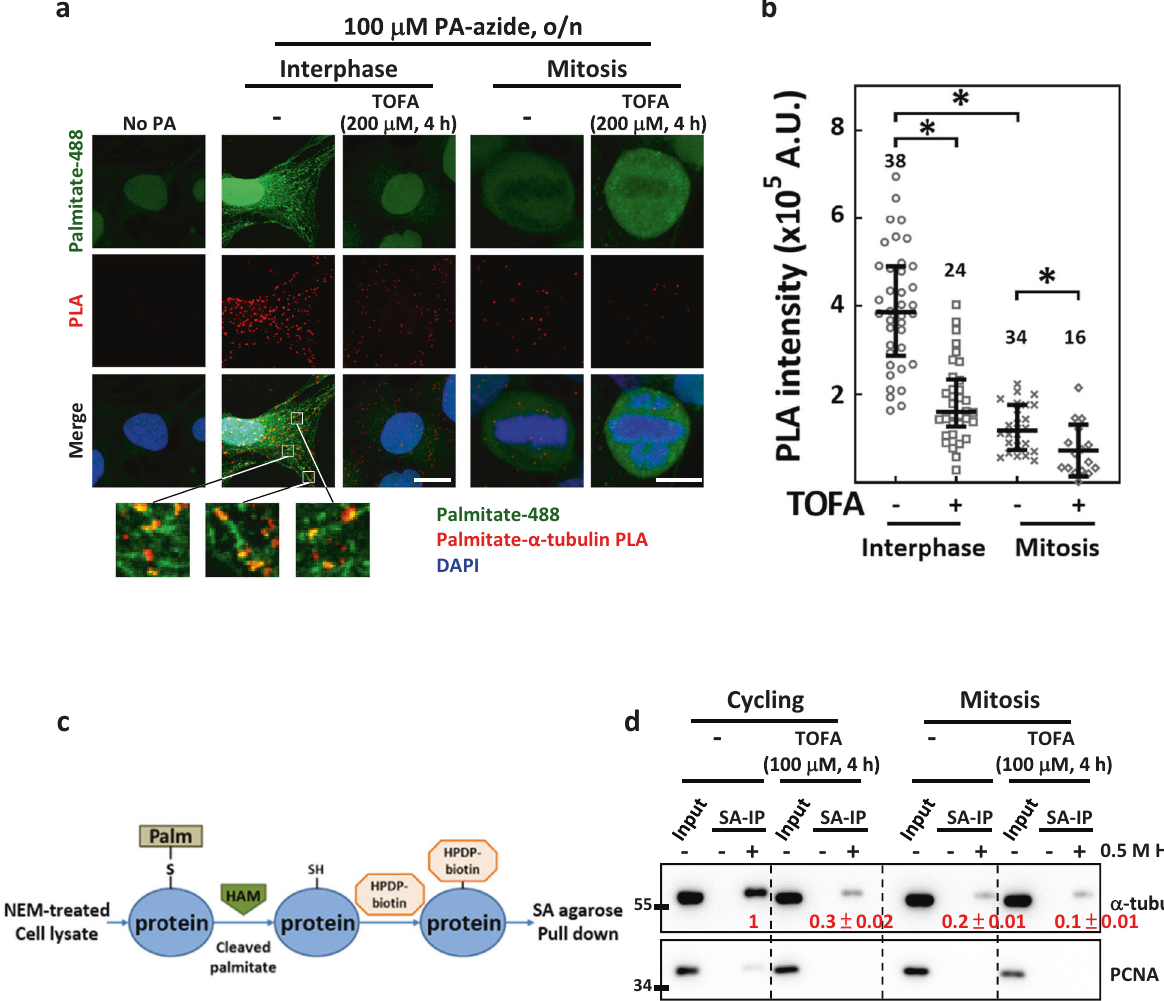
Fig. 5 TOFA reduces tubulin palmitoylation both in interphase and mitosis. Tubulin palmitoylation was reduced during mitosis and further decreased by acute TOFA treatment. a The PLA between α -tubulin and click-labeled palmitate (palmitate-488) was performed using CGL2 cells. The representative images show the control cell (No PA) and the PLA signal between α -tubulin and palmitate (palmitate- α -tubulin PLA) in interphase and mitotic cells that were untreated ( − ) or treated with TOFA as indicated. The insets below show magni fi ed views of regions with colocalization between PLA signals and palmitate-488. b Relative intensity of palmitate- α -tubulin PLA in a single cell was measured. The scatter plot shows the interquartile distribution of the PLA intensity in the group of cells described in ( a ). The numbers above indicate the numbers of cells assayed from two independent experiments. * P < 0.05 by Mann – Whitney rank-sum test. c Illustration of the acyl-biotin exchange assay. d Palmitoylated proteins in MDA-MB-231 cells were puri fi ed using acyl-biotin exchange assay and then subjected to western blotting for α -tubulin detection. HAM addition ( + ) is required for palmitate cleavage, biotinylation, and subsequent puri fi cation of the palmitoylated proteins, and the omission of HAM ( − ) served as the negative control. Input lanes show equal amounts of total tubulin in the cell lysates were applied in each reaction. The western blots show the levels of total cellular tubulin (Input) and palmitoylated fractions of tubulin puri fi ed by streptavidin agarose (SA-IP) from total cell lysates (Input) of untreated ( − ) and TOFA-treated cycling and enriched mitotic cells. The input tubulin was fi rst normalized with PCNA to adjust loading variations and then served to normalize the puri fi ed tubulin. The values below each band indicate the level of puri fi ed α -tubulin after normalizing to input tubulin, relative to untreated cycling cells; mean ± SD from three independent experiments is